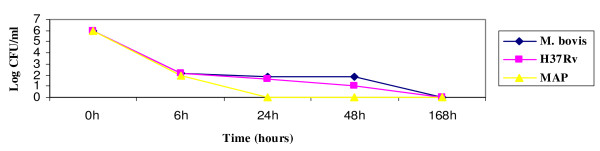
Growth index of M. tuberculosis H37Rv, M. bovis and M. paratuberculosis 1515 in microglial cells BV-2.